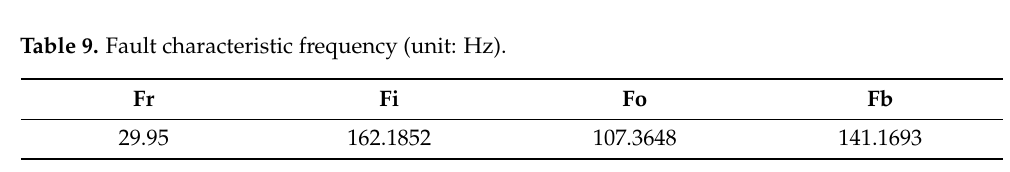
Figure 14. Time-domain and frequency-domain waveform of outer ring slight damage signal.